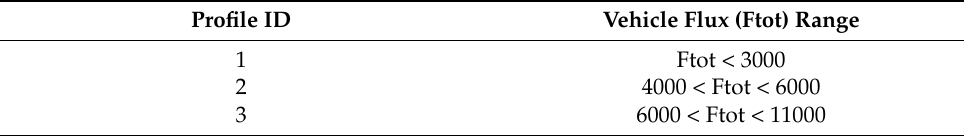
Table 3. Average vehicle flux modulation profiles defined as input in the TREFIC